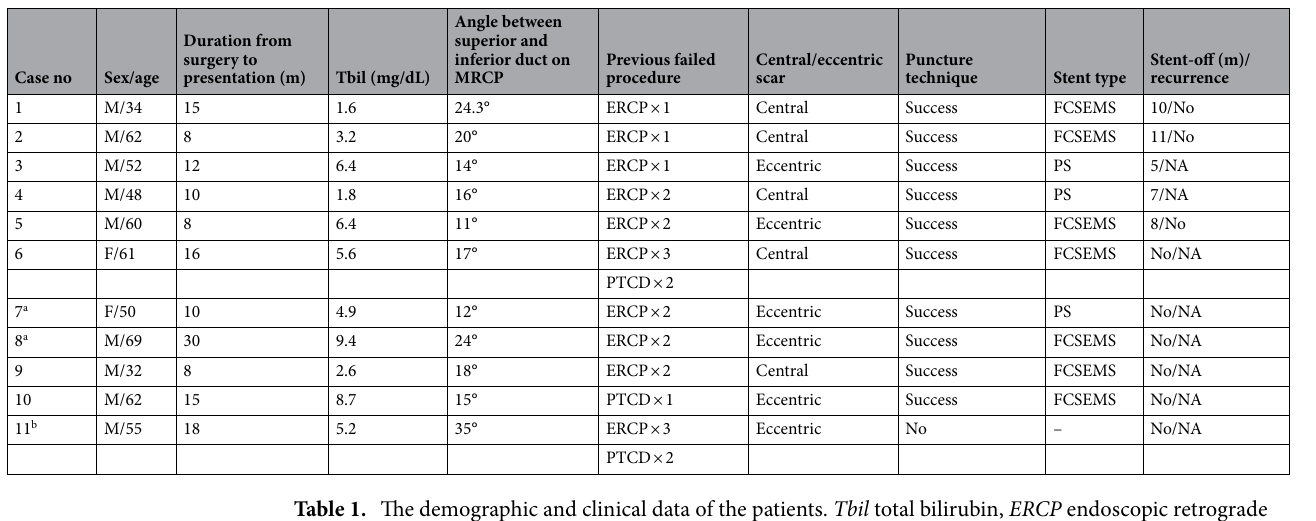
Table 1. The demographic and clinical data of the patients. Tbil total bilirubin, ERCP endoscopic retrograde cholangiopancreatography, PTCD percutaneous transhepatic cholangial drainage, PS plastic stent, FCSEMS fully covered self-expandable metallic stent, NA not available. a managed with hard tip puncture technique under percutaneous transhepatic cholangioscope successfully. b a fistula was found between the biliary anastomosis and the duodenum, across which a plastic stent was placed.